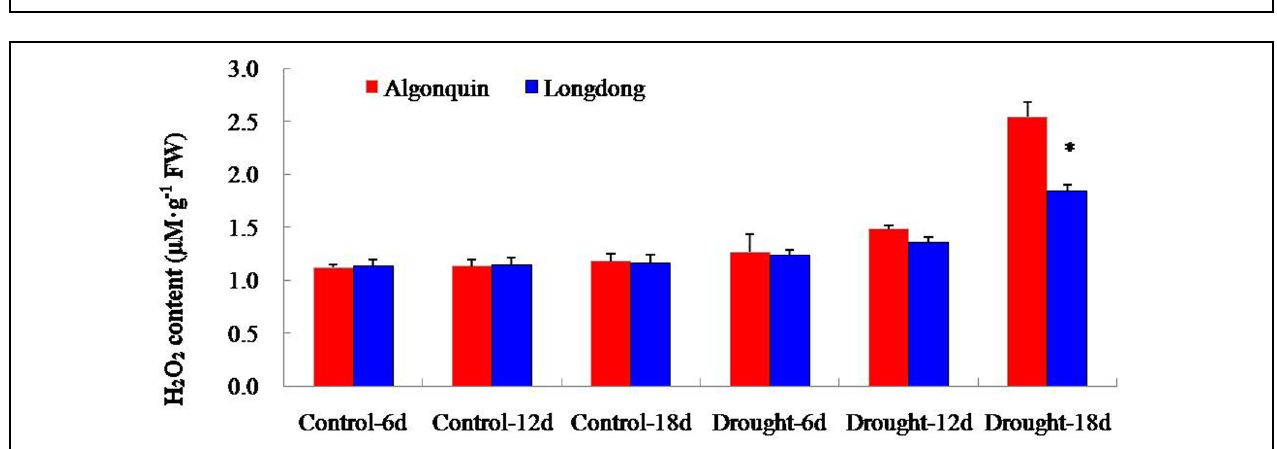
FIGURE 7 | Changes of H 2 O 2 level in two alfalfa varieties after drought treatment. The results shown are means ± SE ( n = 3). Asterisk symbols indicate significant differences from Algonquin at P < 0.05 (Student’s t -test).